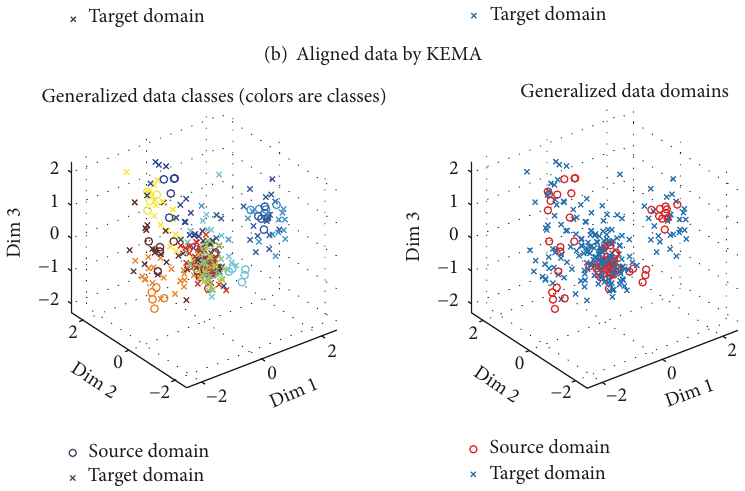
baseline method for five different T train values,